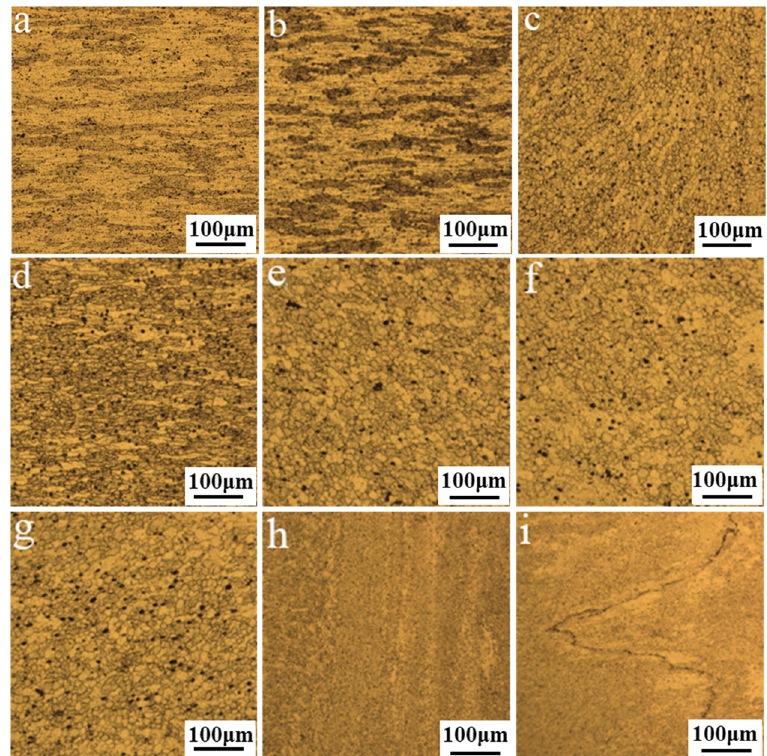
Figure 6. Microstructure under OM at the rotation speed of 400 rpm and welding speed of 350 mm/min in the section of: ( a ) base material (BM); ( b ) heat-affected zone (HAZ); ( c ) thermo-mechanically affected zone (TMAZ) on the AS; ( d ) TMAZ on the retreating side (RS); ( e ) the upper nugget zone (NZ); ( f ) the central NZ; ( g ) the lower NZ; ( h ) the band pattern; and ( i ) the “S” line.